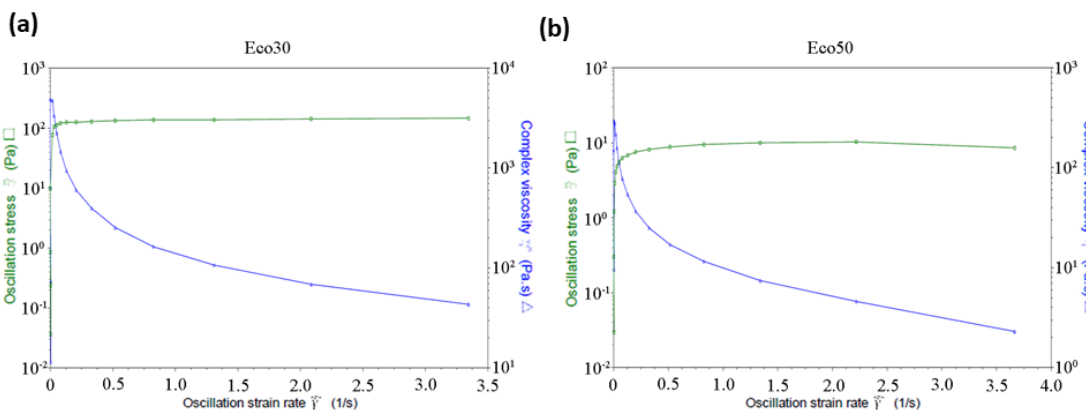
Figure 3. ( a ) Ecoflex30 and ( b ) Ecoflex50 complex viscosity and shear stress versus strain rate.